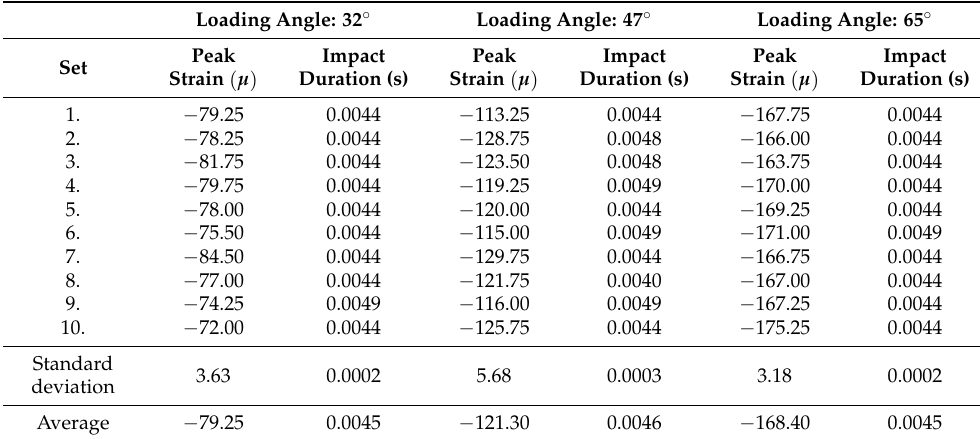
Figure 3. Results of impact experiments. ( a ) Time-domain strain signal of impact load transducer with 10 consecutive impacts; ( b ) a sequence of time-domain strain signal. Table 1. Strain data measured with impact load transducer in impact experiments.